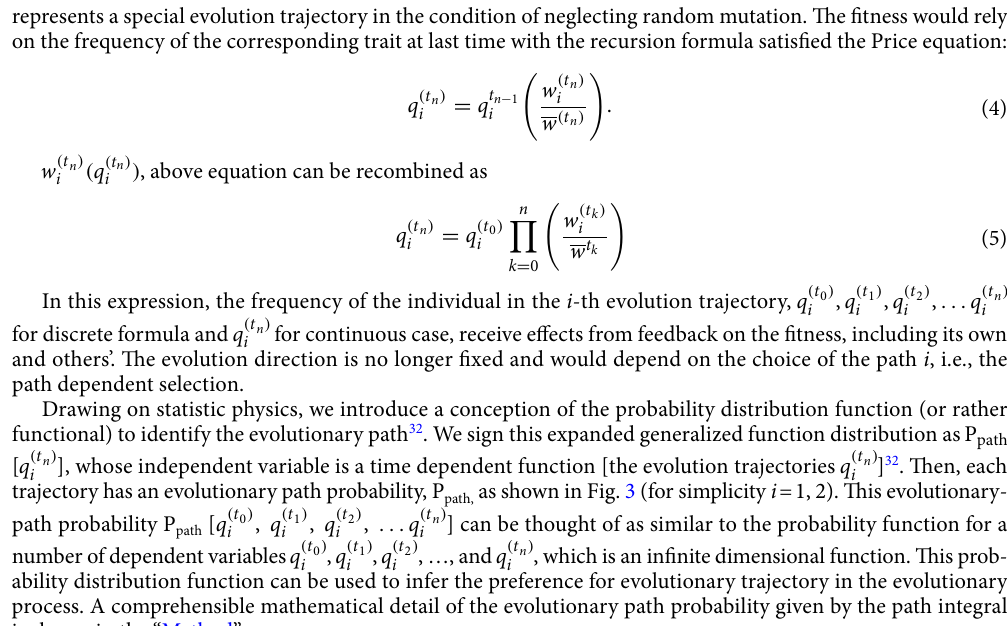
Figure 3. The evolutionary trajectories. There are two evolutionary pathways from time t 0 to time t n , say path z 1 and path z 2 . Each evolutionary path appears with the possibility of P[ q dependent function [the evolutionary trajectories q ( t ) P[ q 1,2 ] can be written as time point t